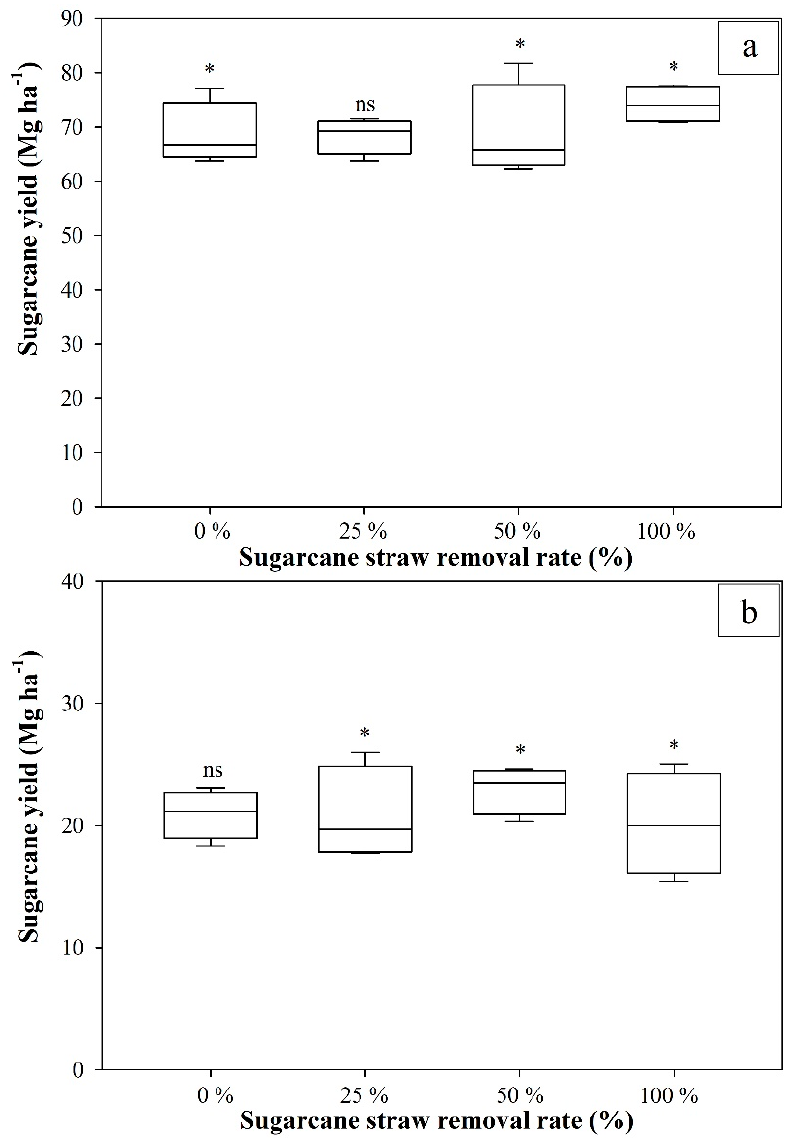
Figure 8. Sugarcane yield (Mg ha − 1 ) changes induced by straw removal rates in Areas 1 ( a ) and 2 ( b ). Shapiro–Wilk Test for normal distribution, where: * significant ( p < 0.05) and ns not significant. When significant, it indicates that the hypothesis for normal distribution is rejected.